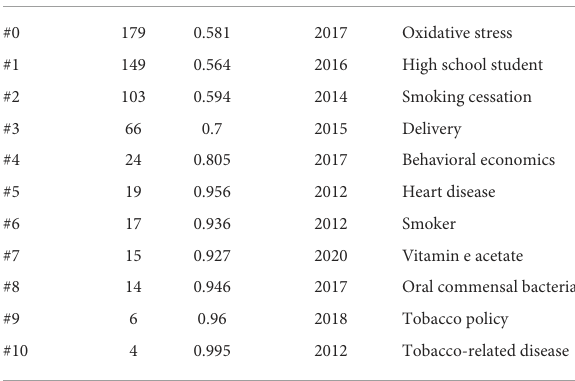
TABLE 6 The 6 highest K-value co-cited reference groups. TABLE 7 Keyword clustering analysis of e-cigarette